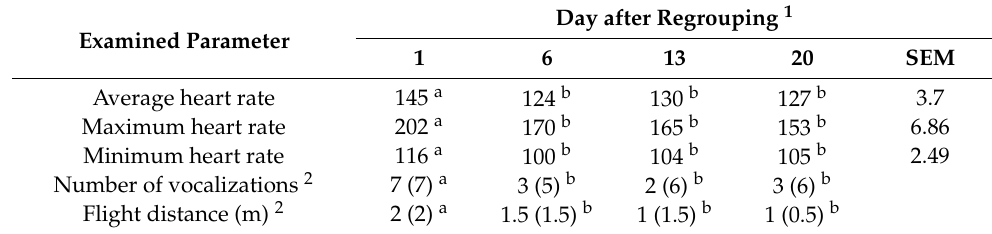
Table 2. Effect of regrouping on the average, minimum and maximum heart rate (beats/min), the number of vocalizations per min, and the flight distance (m) during the isolation—flight distance test in Chios